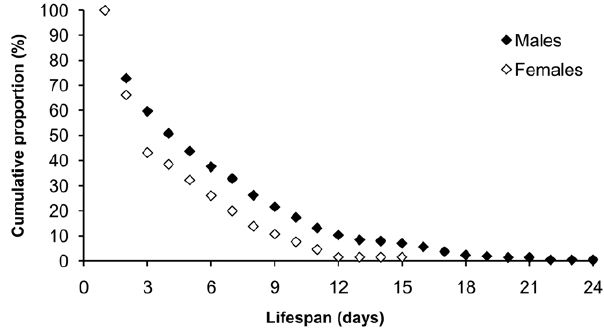
Figure 2. Cumulative proportions of recaptures of the Rosalia longicorn in dependence on observed ‘‘lifespan’’. The lifespan was counted as the number of days between the first and last capture of given individual. Data from the mark-recapture study were combined from years 2008 and 2009. ( N males =213, N females =65 ).